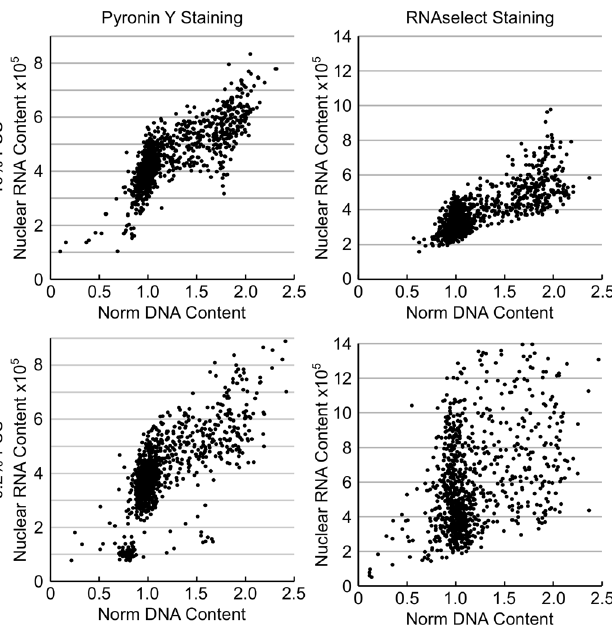
Fig 6. Determination of cellular quiescence using nuclear RNA staining. HT29 cells growing in 10% FCS or in 0.2% FCS for 72 hours were fixed and stained with Pyronin Y or RNAselect for determination of RNA and total DNA content. Plots of total nuclear DNA content versus total nuclear RNA